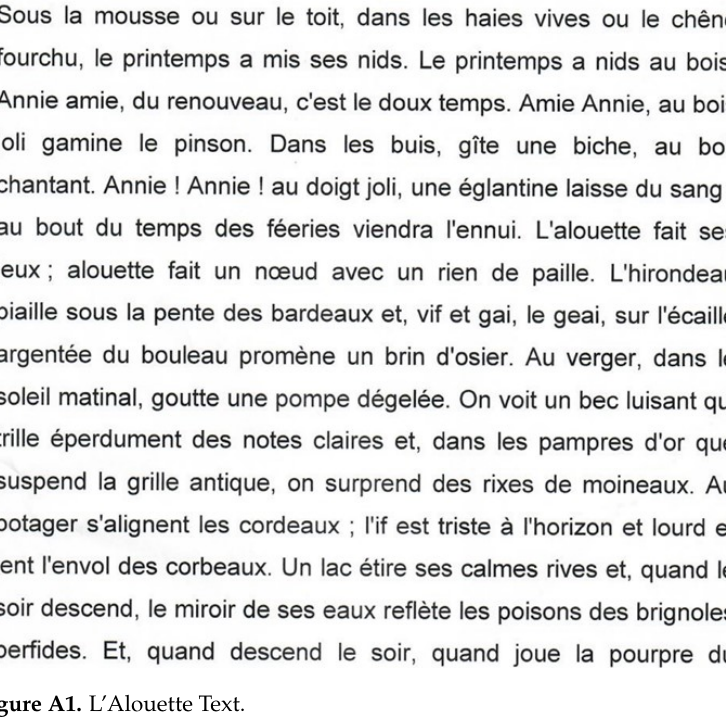
Figure A1. L’Alouette Text.